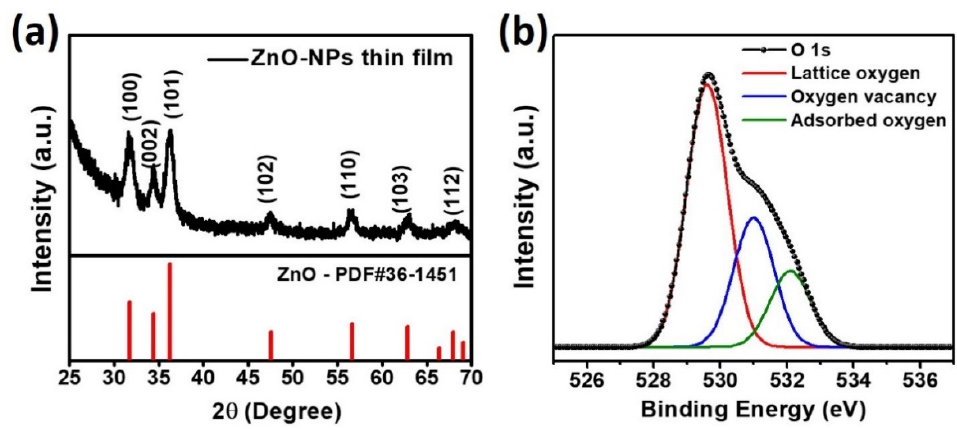
Figure 2. ( a ) X-ray diffraction pattern and ( b ) O 1s XPS spectra of as-synthesized ZnO-NPs.